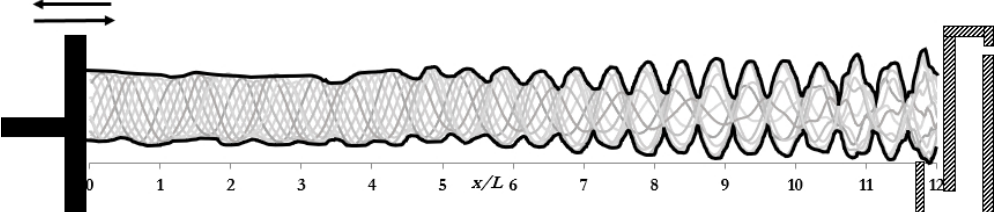
Figure 6. Overlapping of several snapshots of the flume surface during a wave period as a function of x / L . In the marked line the envelope of the quasi-standing field is represented ( H = 2.5 m , T = 8 s ). Along abscissas 4 L < x < 6 L , the transition from the incoming waves and the quasi standing field is